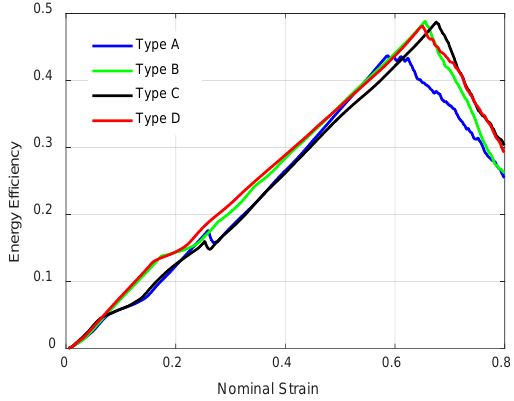
Figure 26. Energy efficiency curves of NPR lattice structures.